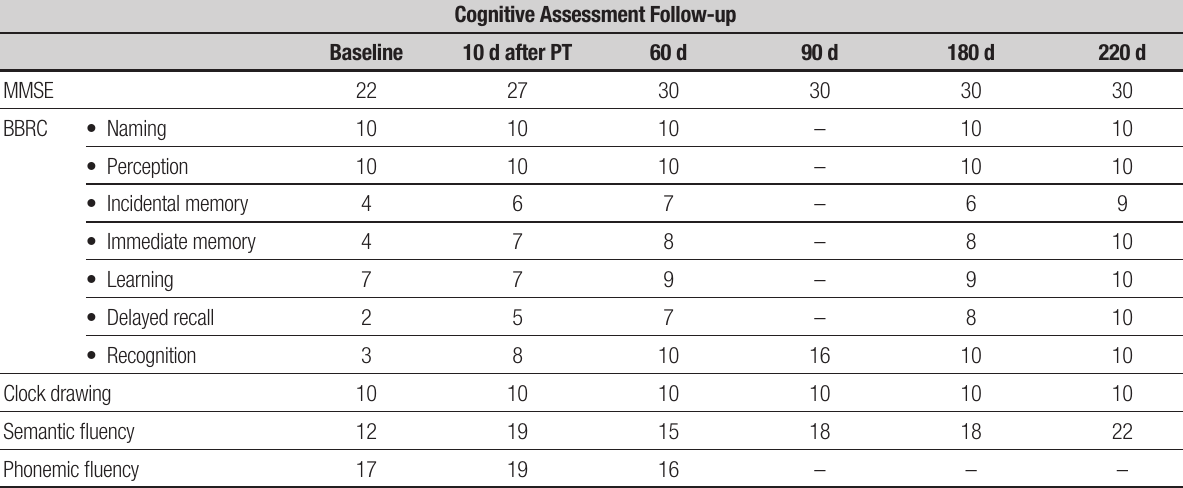
Table 1. Cognitive performance on baseline and follow-up.